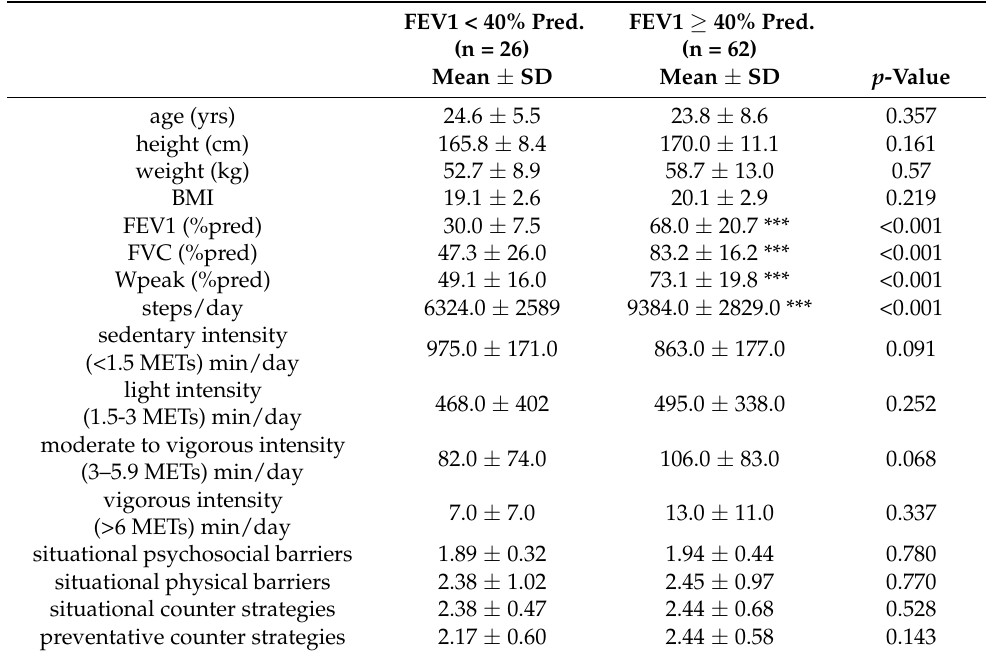
Table 4. Anthropometric characteristics, lung function and steps/day, and intensity of physical exercise of participants by FEV1 < 40%pred./ ≥